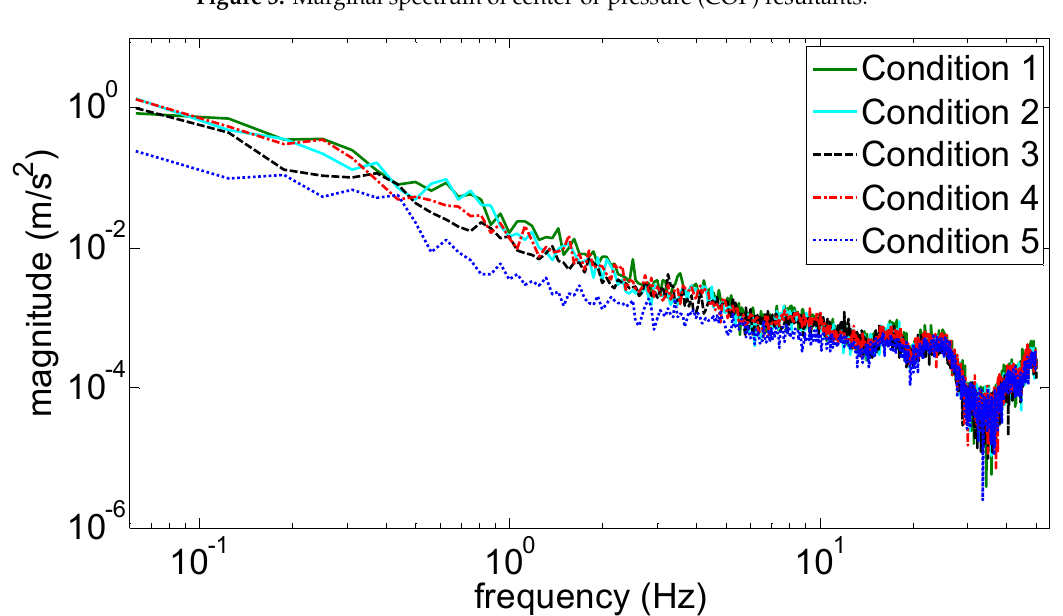
Figure 4. Marginal spectrum of acceleration resultants.